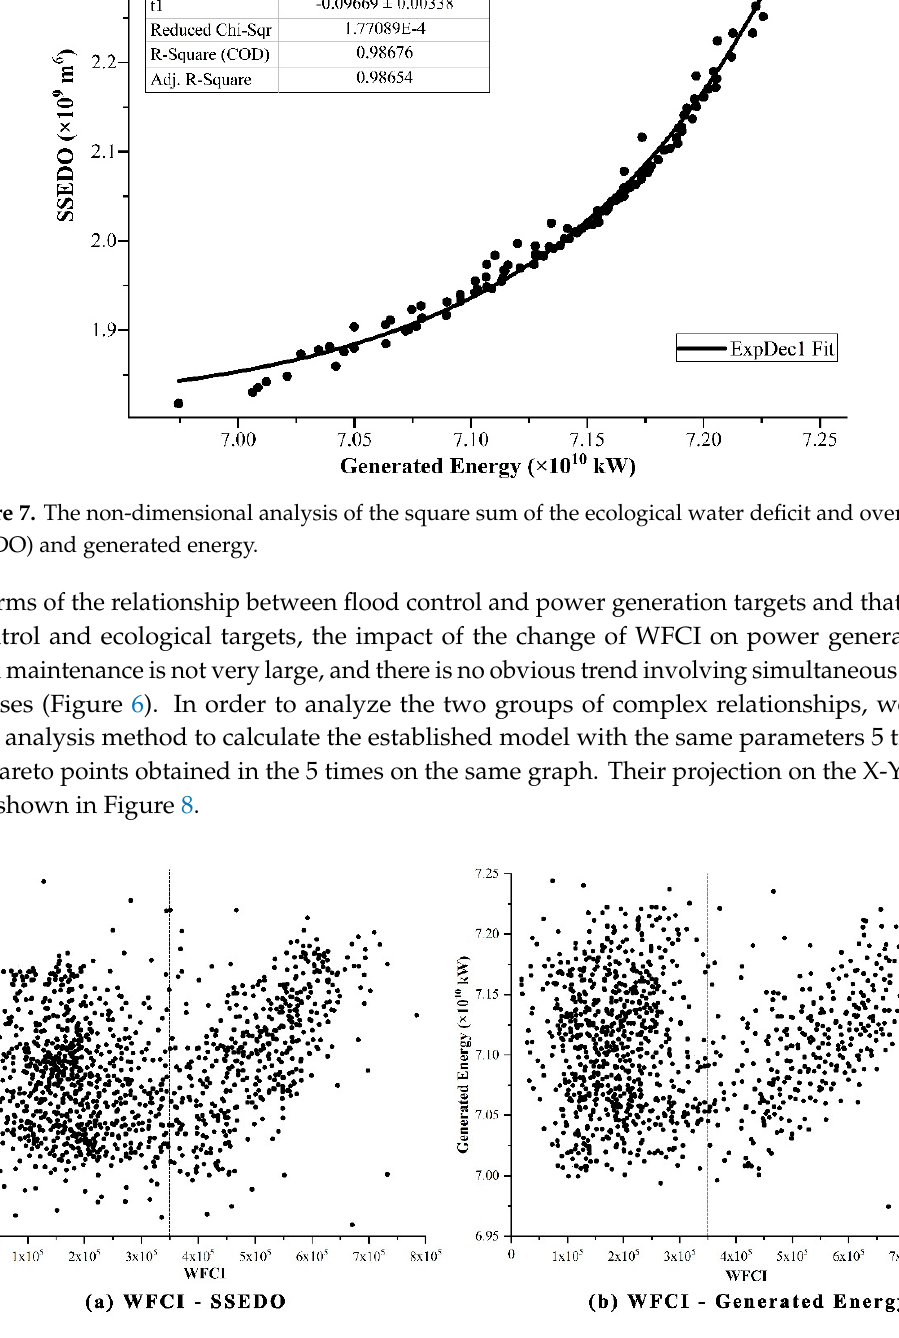
Figure 8. The biaxial projection graph of Pareto frontier sets.